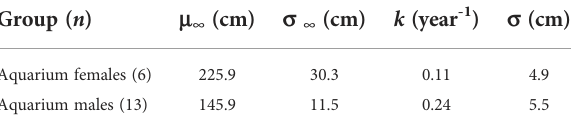
TABLE 5 Estimated growth parameters with individual variability in DW ∞ . Group ( n